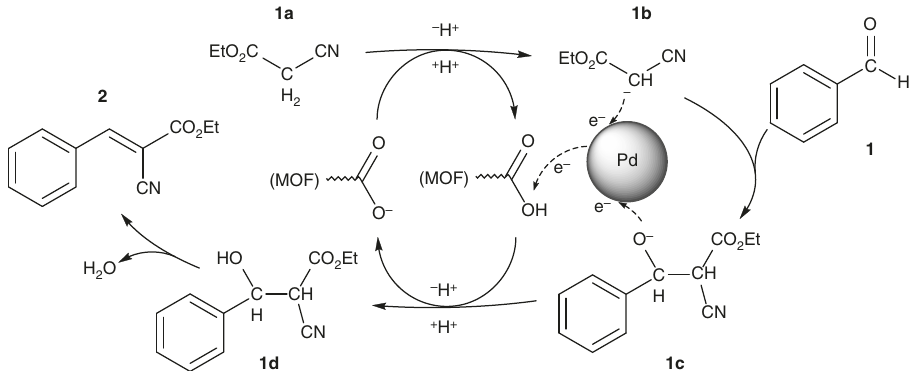
Fig. 5 Proposed mechanism of Pd 0 -enhanced base-catalysed Knoevenagel condensation. The Pd NP acts as an electron reservoir to stabilise anionic intermediates ( 1b and 1c ) and facilitates the regeneration of MOF Lewis basic sites via